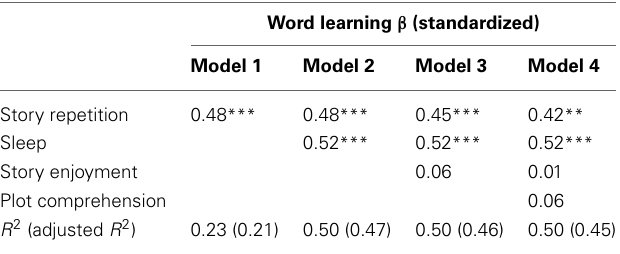
retention 2.5h after story exposure based on story repetition, sleep, story enjoyment and plot